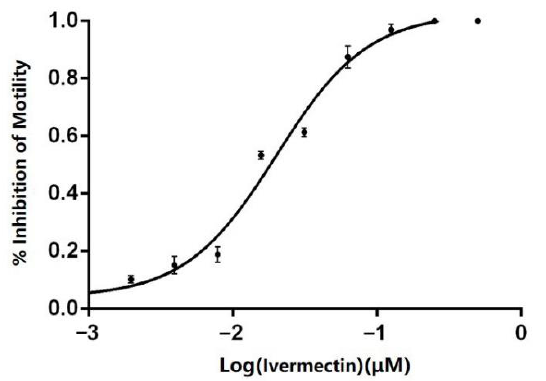
Figure 8. Larva migration inhibition test